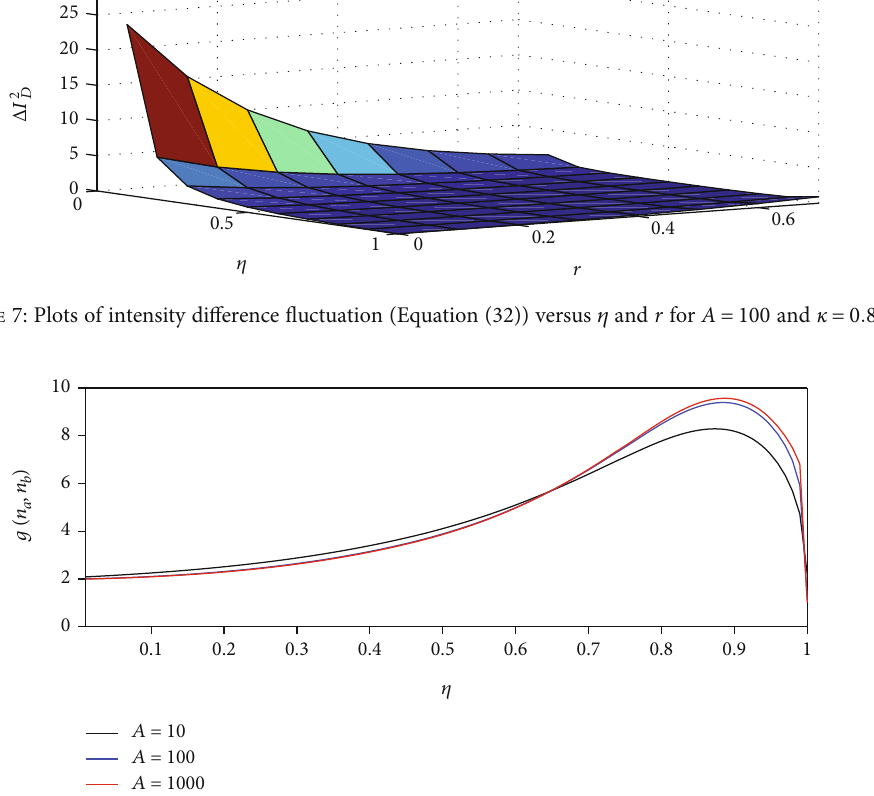
Figure 8: A plot of the photon number correlation versus η (Equation (35)) of the two-mode cavity radiation for κ = 0 : 8 and r = 0 : 5 and di ff erent values of A .